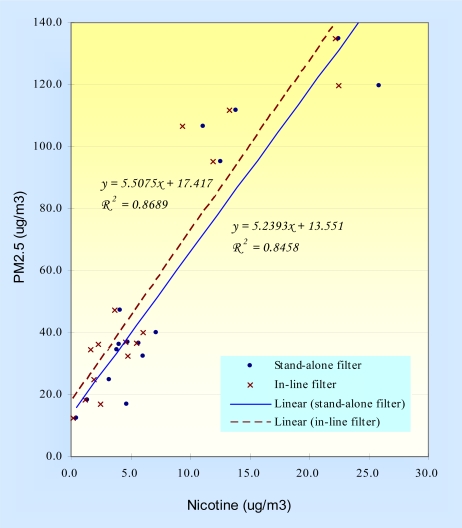
Correlations between PM2.5 concentrations and nicotine concentrations using two different sampling designs.